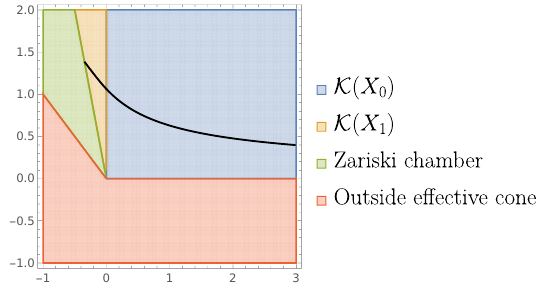
Figure 6 . Effective cone of CICY #7885, showing Kähler cones of CYs X 0 and X 1 , as well as an adjacent Zariski chamber, with a geodesic curve